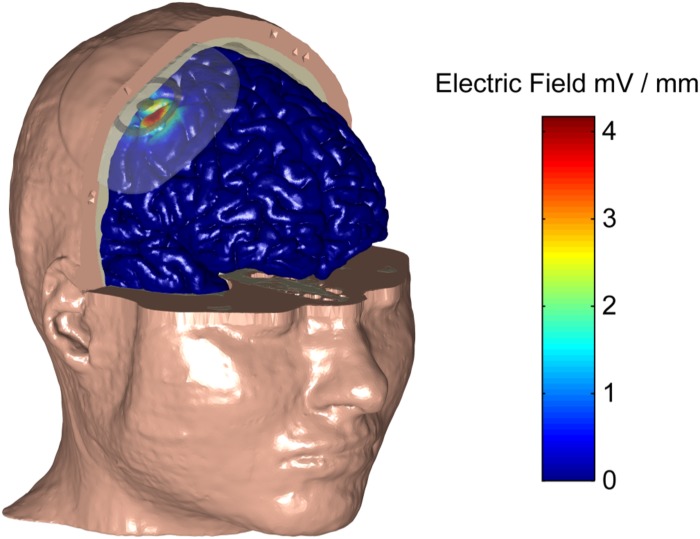
A human head electro-anatomical computational model was used to illustrate the concept of ECS with a concentric-ring electrode. Part of the skin and skull have been made transparent to reval the ECS concentic-ring electrode, which consists of a central disc and outer ring electrode (gray) embedded in an insulating silicone layer (partially transparent). The disc and ring electrode are in contact with the skull but insulated from the skin by the silicone layer. The CSF is not shown for simplicity. The electric field strenght on the cortical surface (see color bar) caused by a 1 mA current applied through the ECS electrode is shown. Using this electrode design, 1 mA ECS creates a relatively focused electric field in the cortex with the maximum electric field strength of 3.82 V/m.